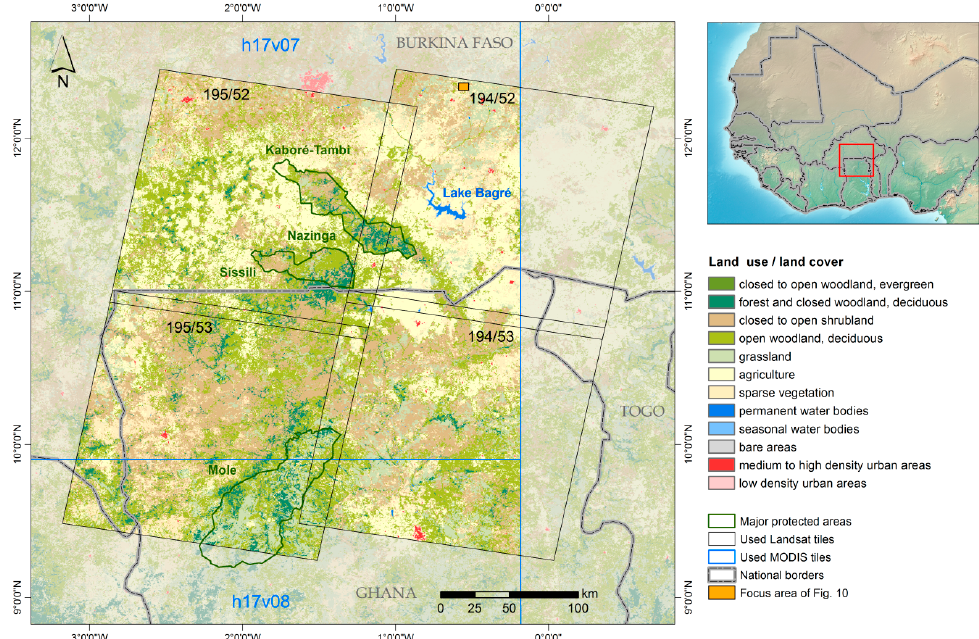
Figure 1. Overview over the study area in southern Burkina Faso and northern Ghana, delineated by the intersection of four Landsat tiles (194/52, 194/53, 195/52, 195/53) with two MODIS tiles (h17v07, h17v08). Underlying land cover classification has a 250 m spatial resolution for the year 2006 (data source: Gessner et al. [19]).